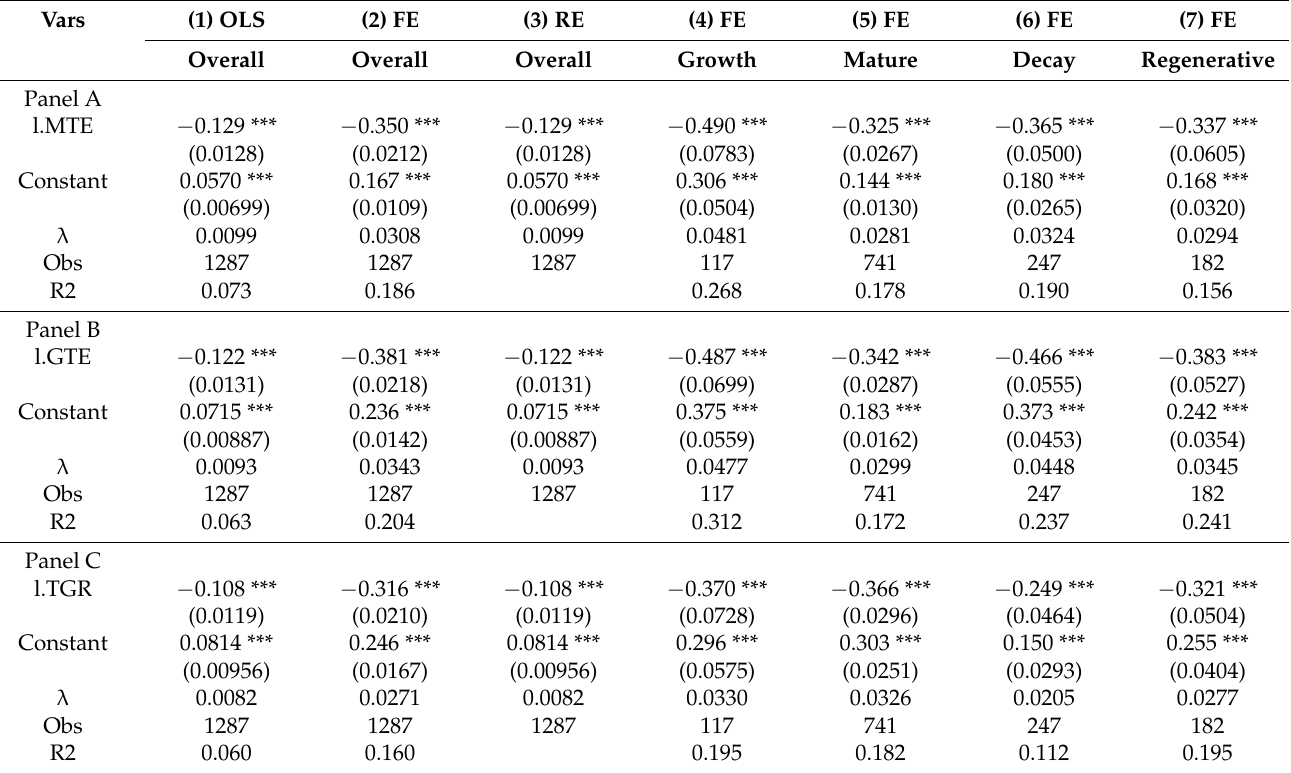
Table 3. Summary of absolute β convergence results of input-output allocation efficiency space for high-quality economic development of mining